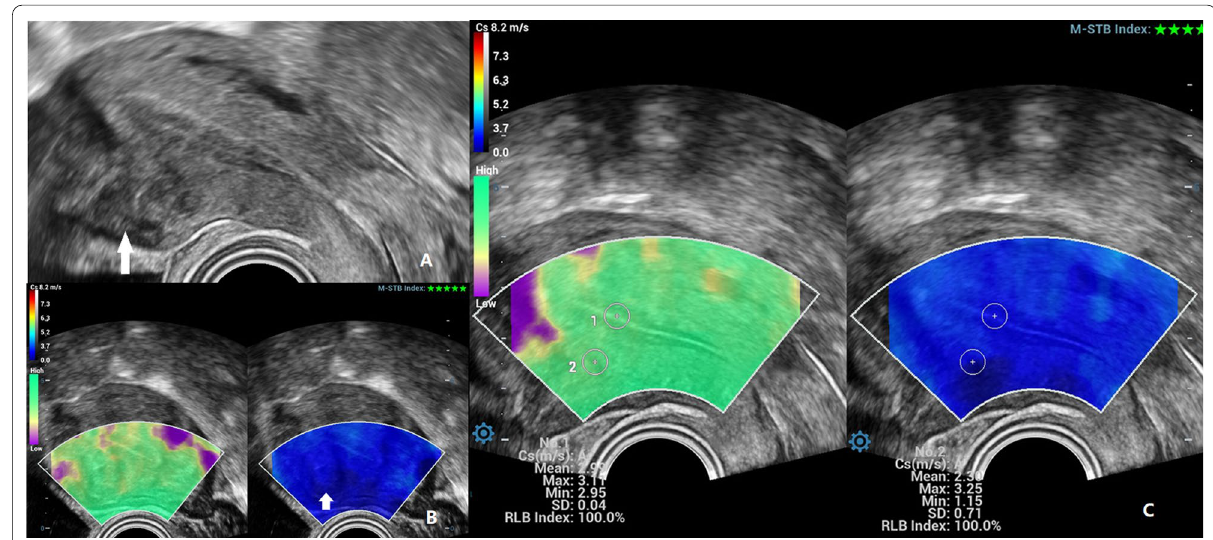
Fig. 4 SWE used to diagnose of uterus fibroids. A Transvaginal ultrasound showed a hypoechoic lesion in the anterior inferior uterine segment (marked with a white arrow). B SWE showed a lighter blue color pseudocapsule that circling around the fibroid (marked with a white arrow). C Locating the region of interest at the lesion 2 and shear wave speed (Cs) measured